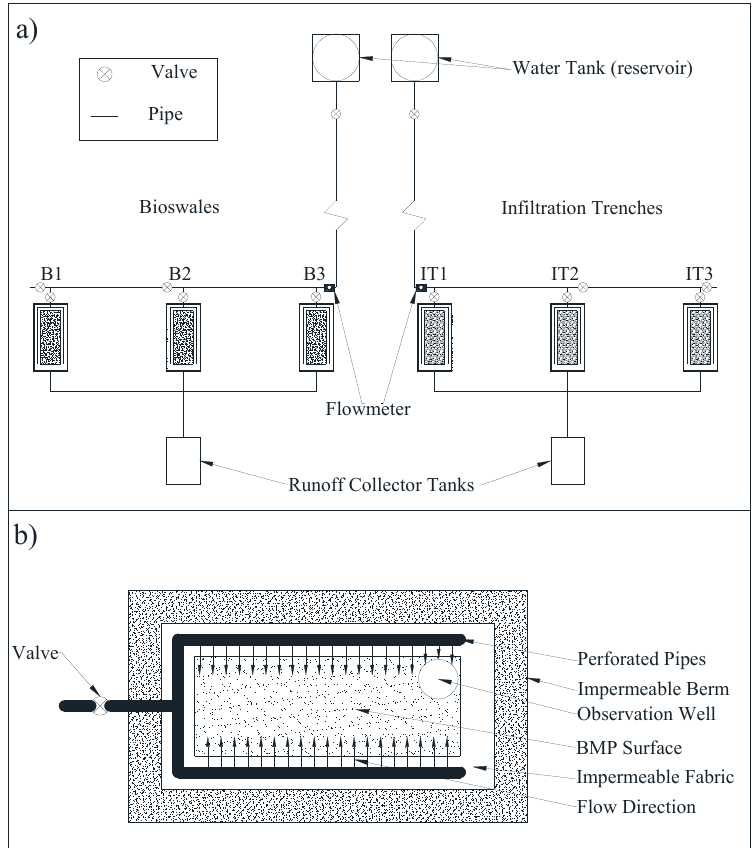
Figure 3. ( a ) Schematic plan view of the best management practices (BMPs) and tests layout; ( b ) magnified version of a representative